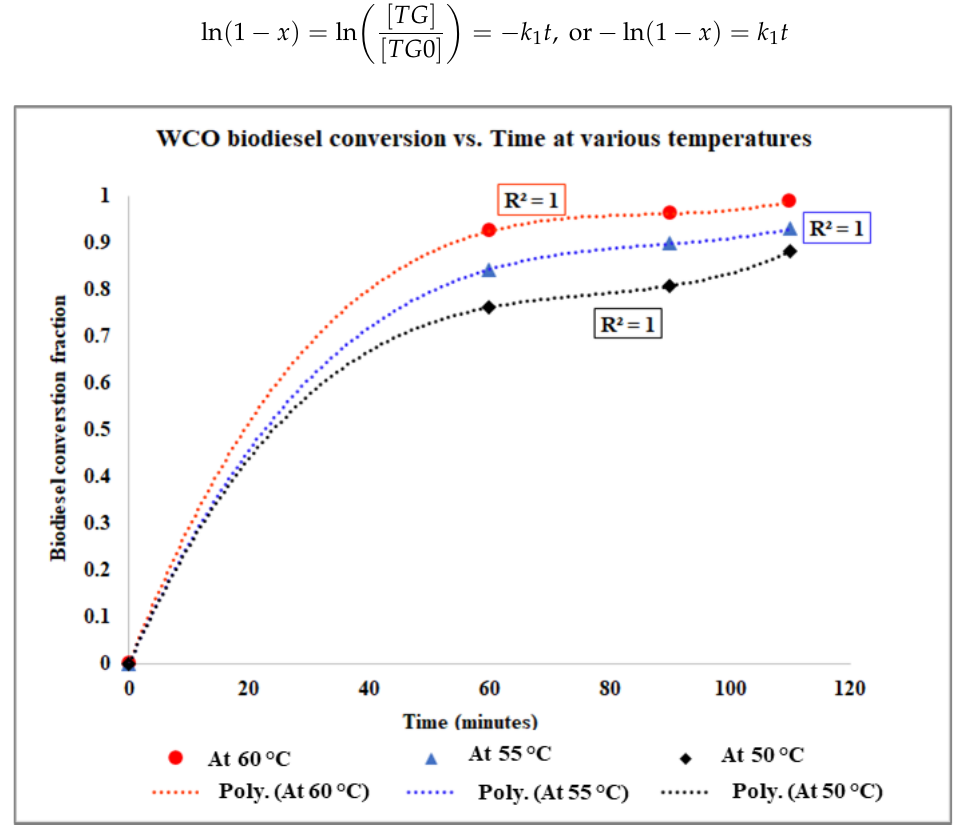
Figure 18. WCO biodiesel (WCB) conversion at various times for the given temperatures.